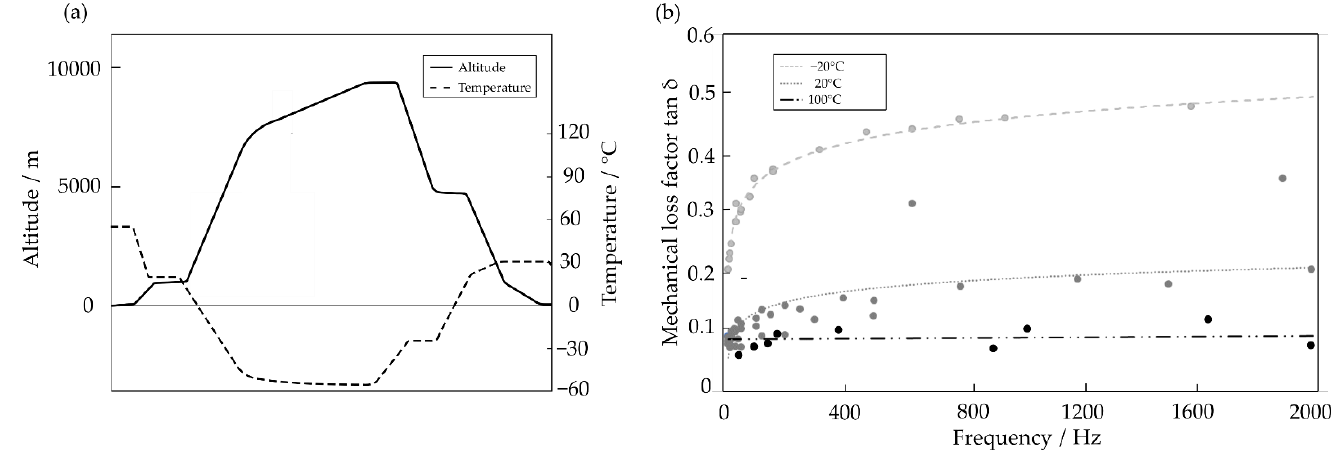
Figure 9. ( a ) Schematic flight cycle with a typical temperature curve; ( b ) Change of the mechanical loss factor in dependency of standard sinusoidal vibration test’s excitation frequency (compare RTCA DO-160G).